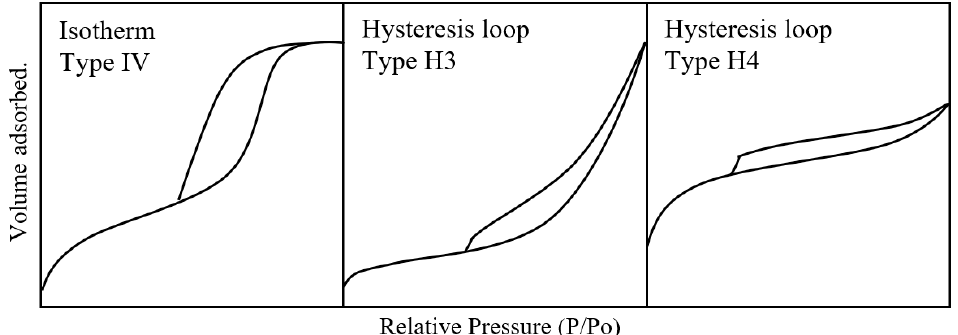
Figure 3. IUPAC classification of isotherms and hysteresis loops commonly observed on shales. (Modified from Rouquerol, 2014 [58]).